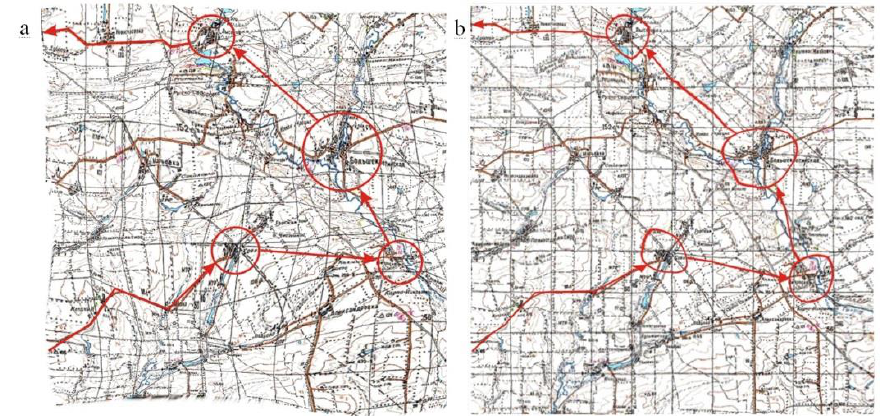
Fig. 10. Decision for liquidation the chemical pollution consequences: a – on the anamorphed map; b - anamorphed map morphing into Euclidean